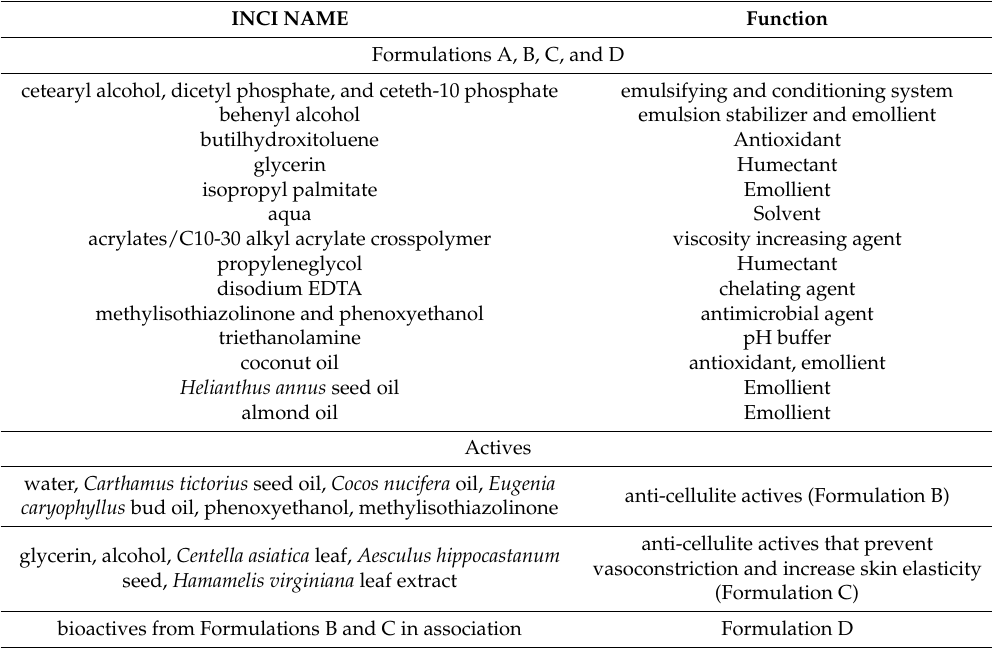
Table 1. Qualitative description of the developed